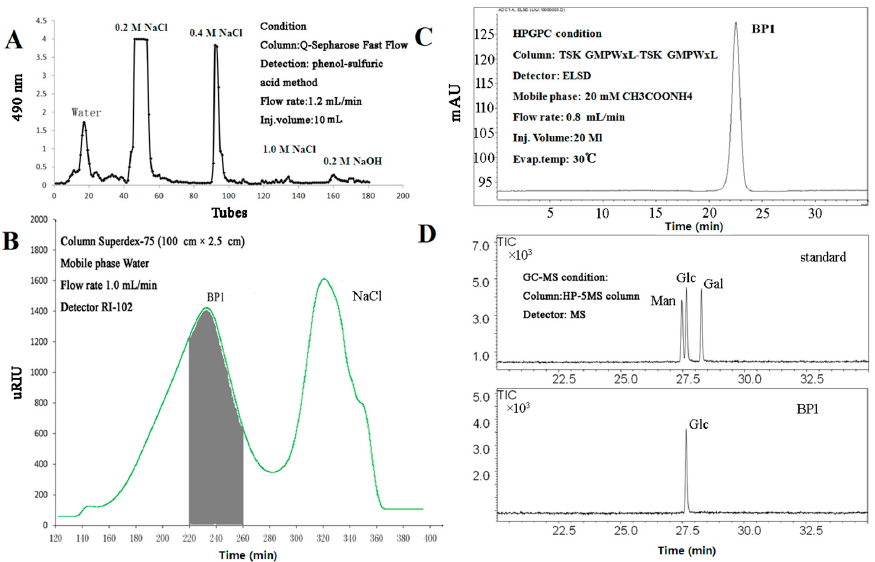
Figure 1. ( A ) The Q-Sepharose column chromatography of crude polysaccharide extracted from Lobelia chinensis ; ( B ) gel filtration chromatography of the major fraction (0.2 NaCl elution) on Superdex 75; ( C ) homogeneity of BP1 as measured by high performance gel permeation chromatography (HPGPC); ( D ) monosaccharide composition of BP1 (upper: reference standards; lower: BP1).